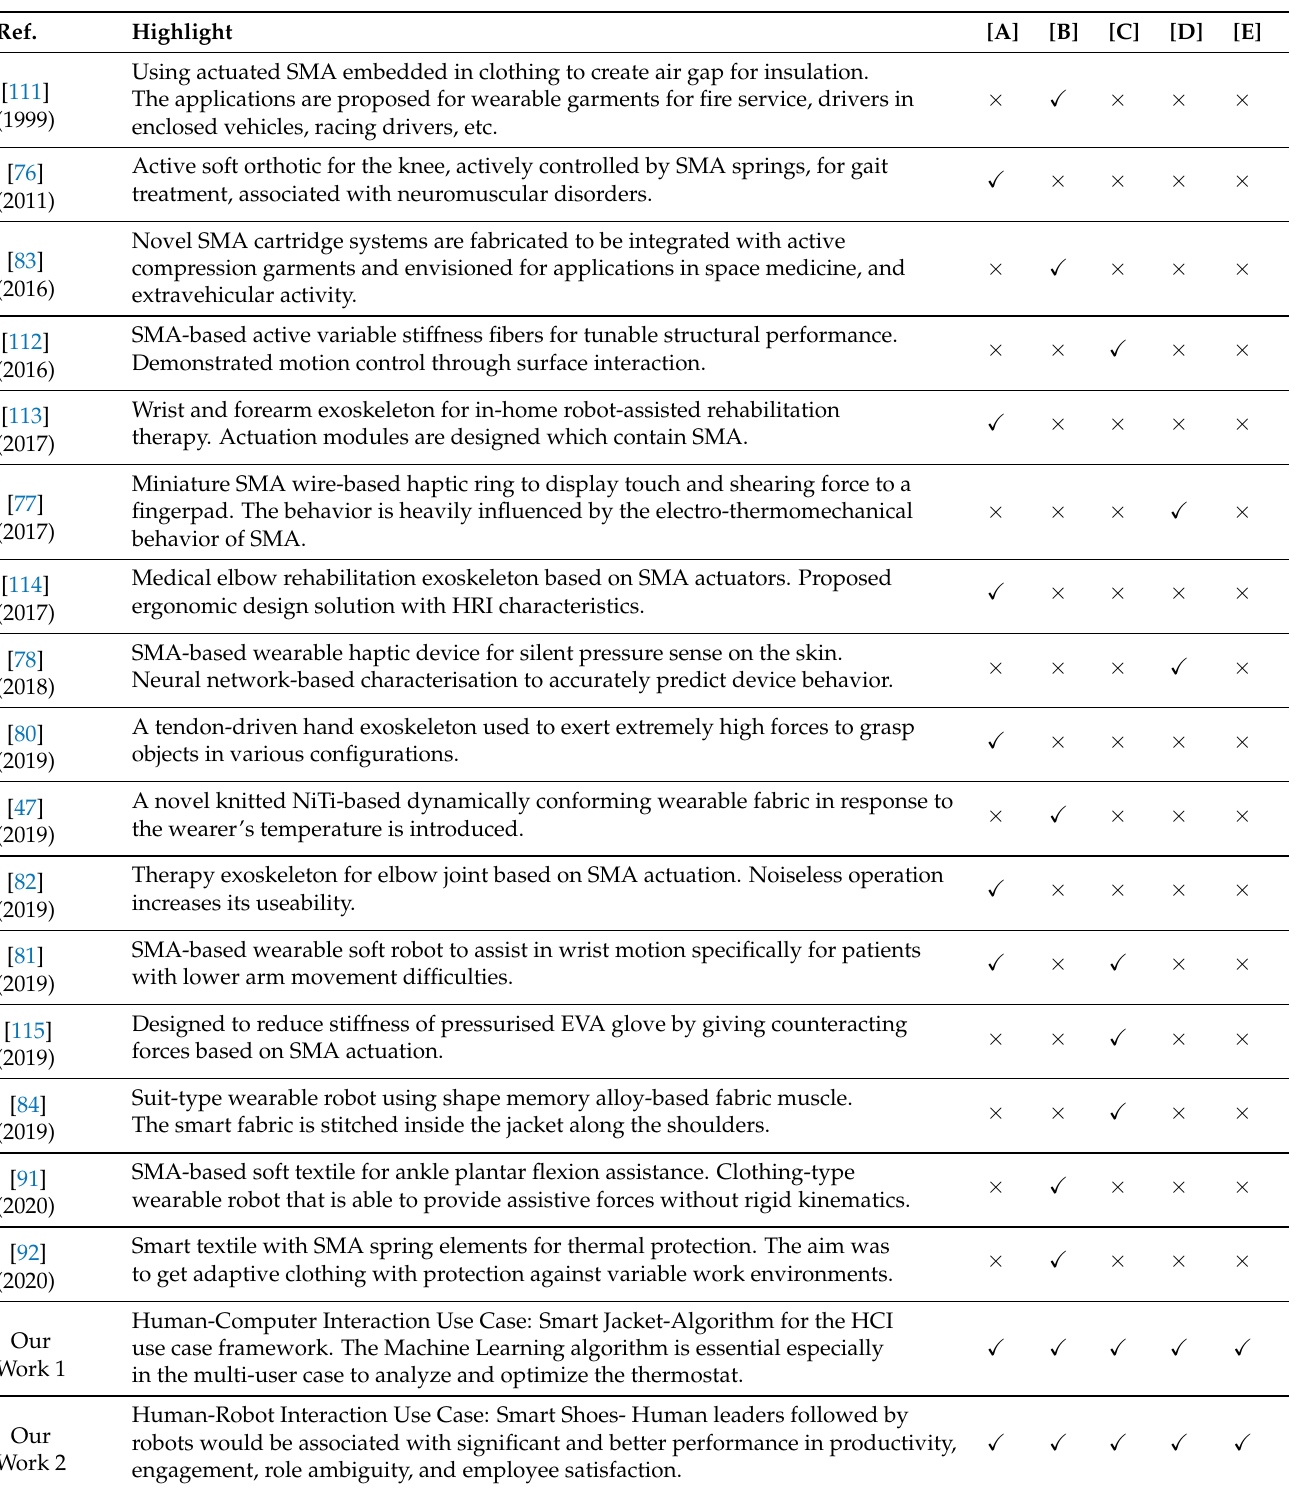
Table 1. State-of-the-Art SMA wearables. Comparison of proposed use cases and categorization on the basis of application in [A]-Rehabilitation, [B]-Protection, [C]-Assistance, [D]-Human Robot/Computer Interaction, and [E]-Industry